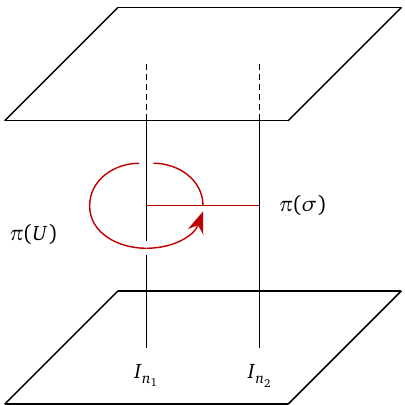
( ∂ X ) . The 2 σ . 1 ) σ = 0 , n 1 2